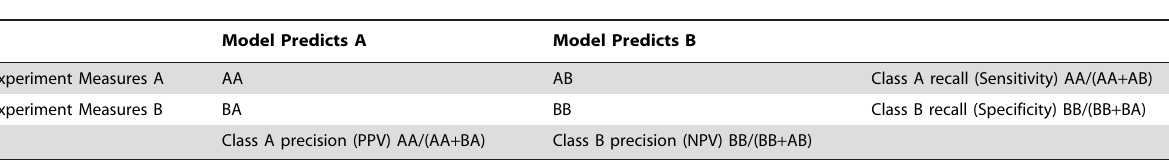
Table 5. Binary classification confusion